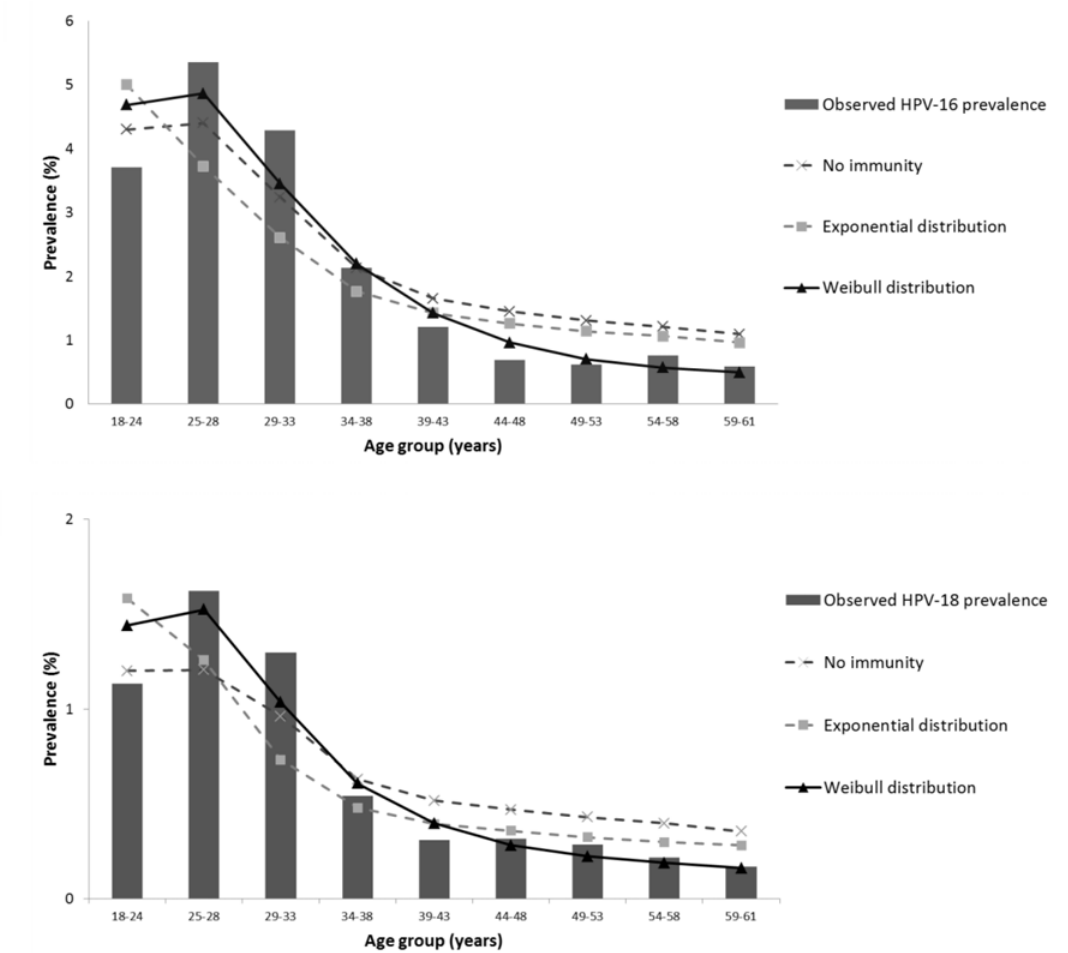
Figure 2. Comparison of the observed and estimated age-specific HPV prevalence. The estimated prevalence is given by the best fitting models of the different scenarios. These scenarios include no acquired immunity after clearing an infection (exponential distribution for the duration of infection); exponentially distributed durations; Weibull distributed durations. (A) shows the results for HPV-16; (B) for HPV-18.